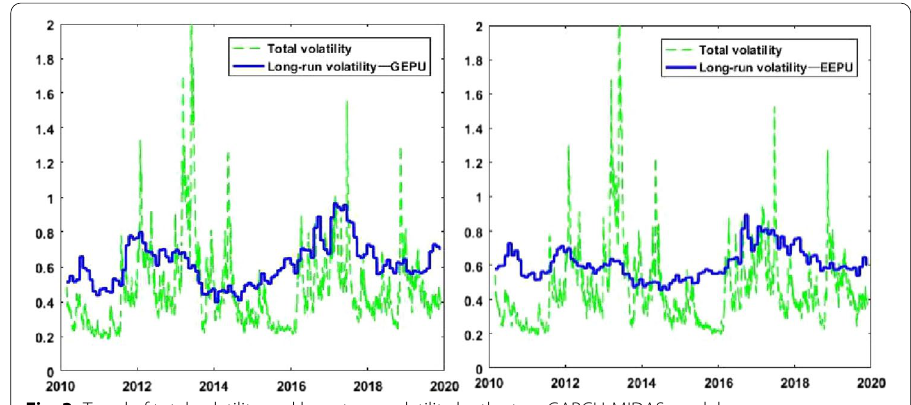
Fig. 3 Trend of total volatility and long-term volatility by the two GARCH-MIDAS